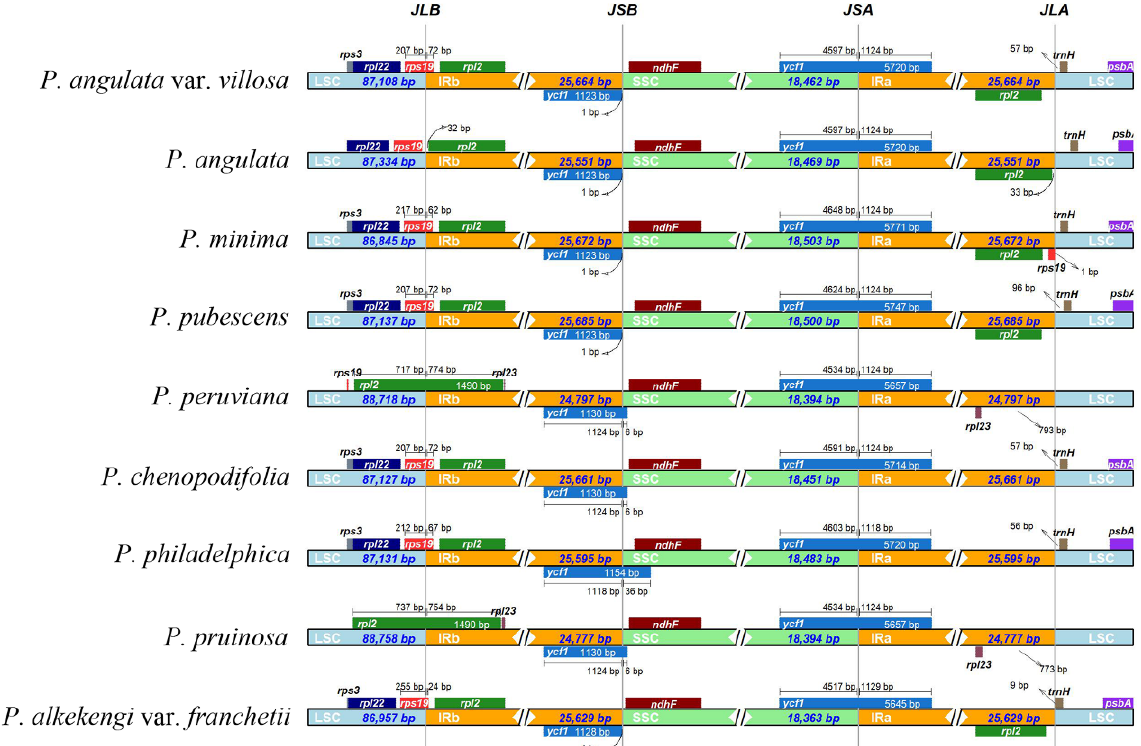
Figure 7. Comparison of the borders of the IR, SSC and LSC regions among nine Physalis plastomes. Numbers above indicate the distances in bp between the ends of the genes and the border sites.